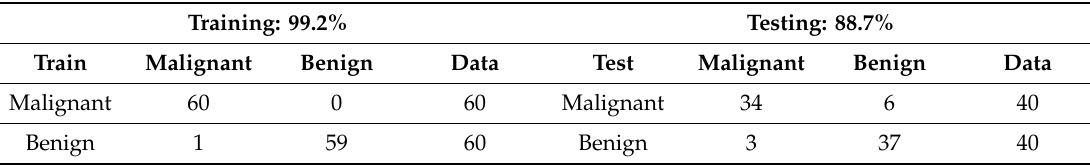
Table 2. Confusion matrix of SVM binary classification—Malignant vs. Benign. Training: 99.2% Testing: